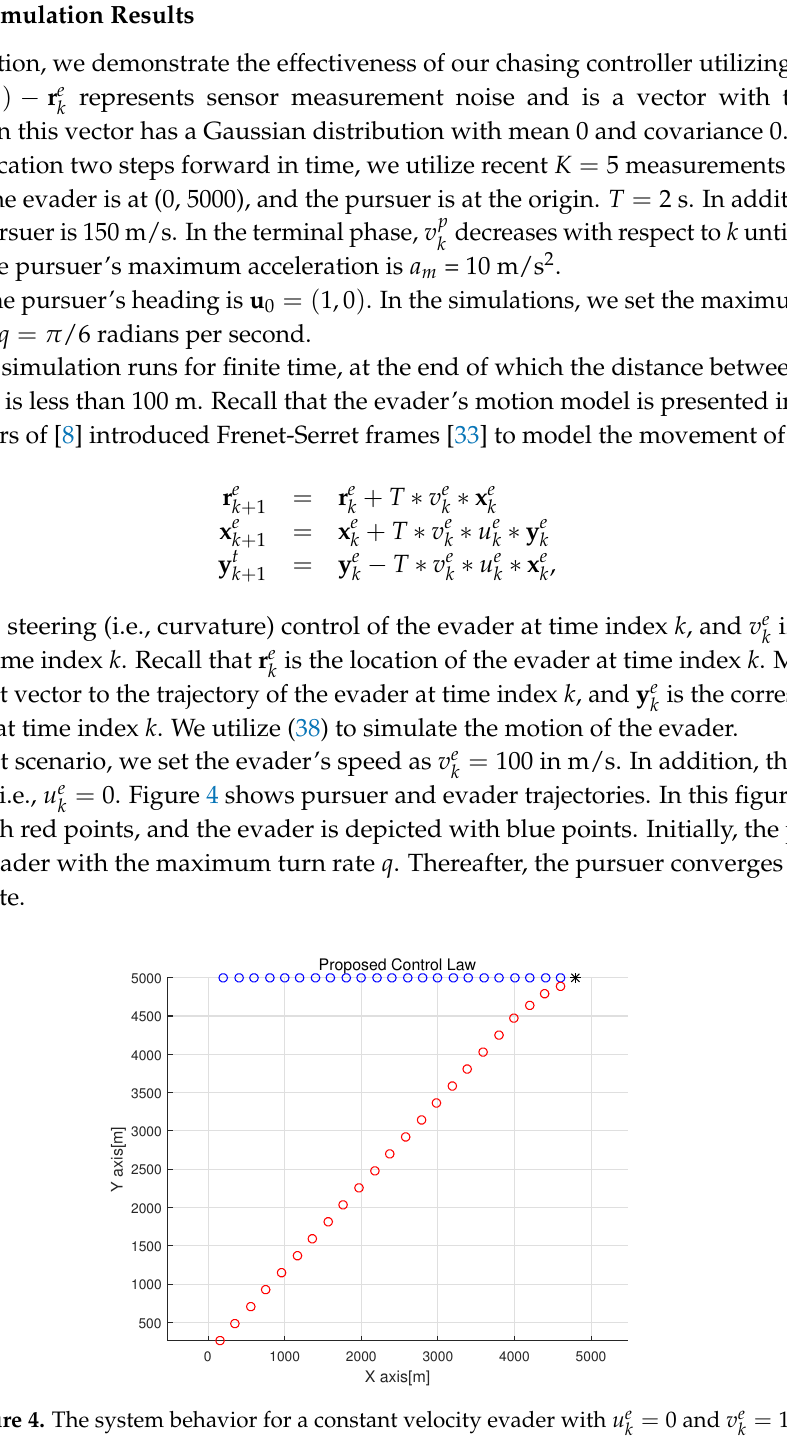
Figure 4. The system behavior for a constant velocity evader with u e